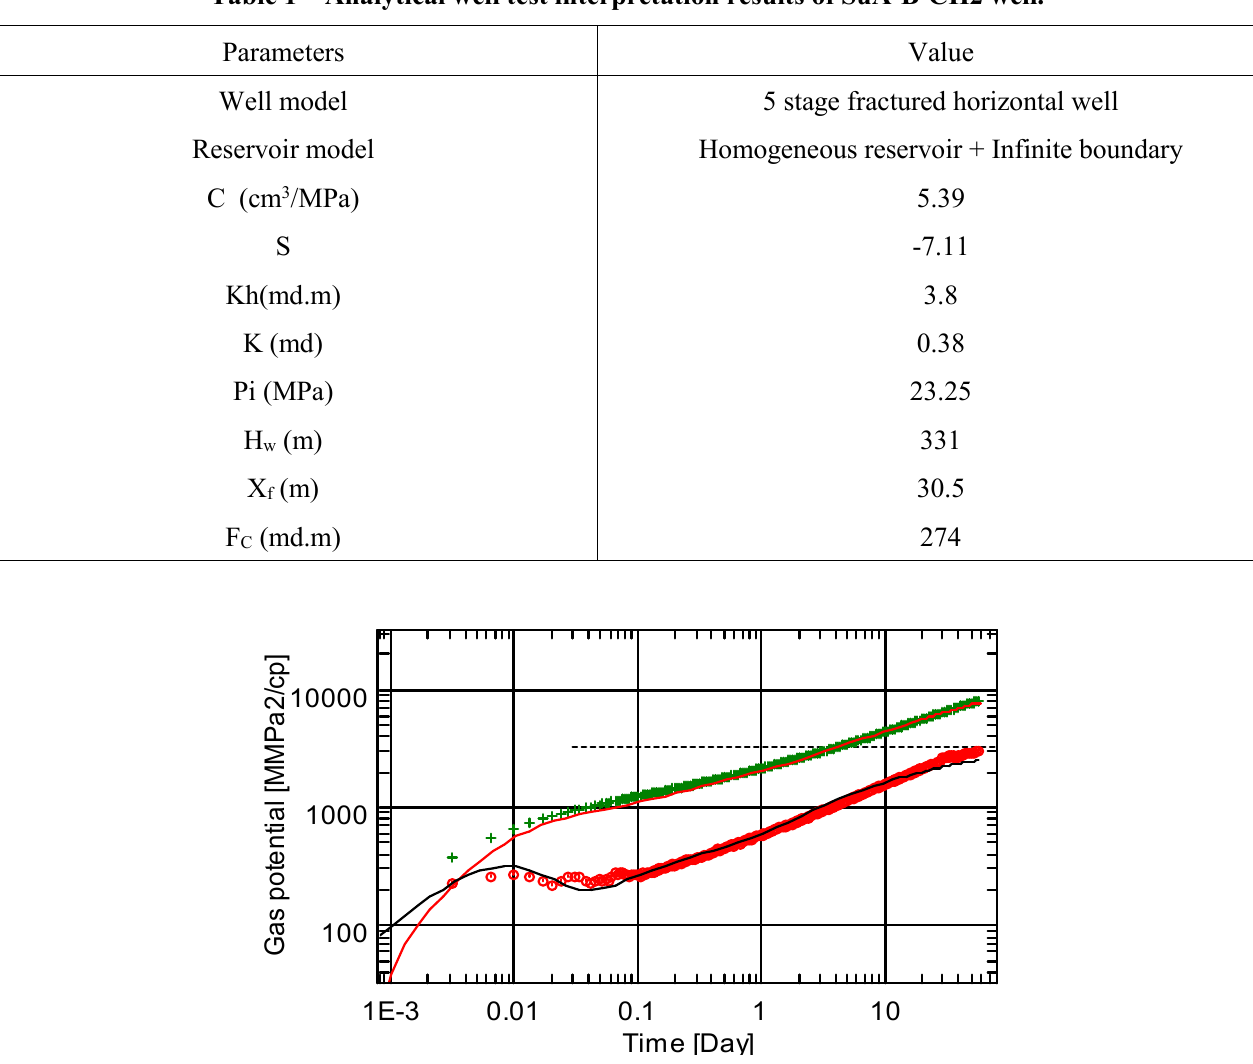
Figure 6—Log-log curves of analytical well test of SuA-B-CH2 well.